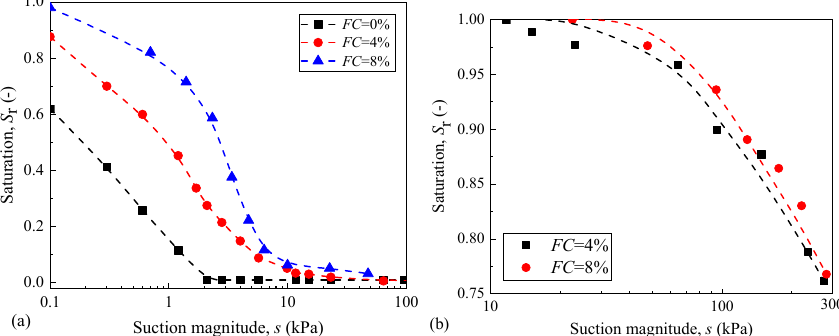
Figure 4. ( a ) SWRCs of inter-aggregate pores at different FC s; ( b ) SWRCs of intra-aggregate pores at different FC s.